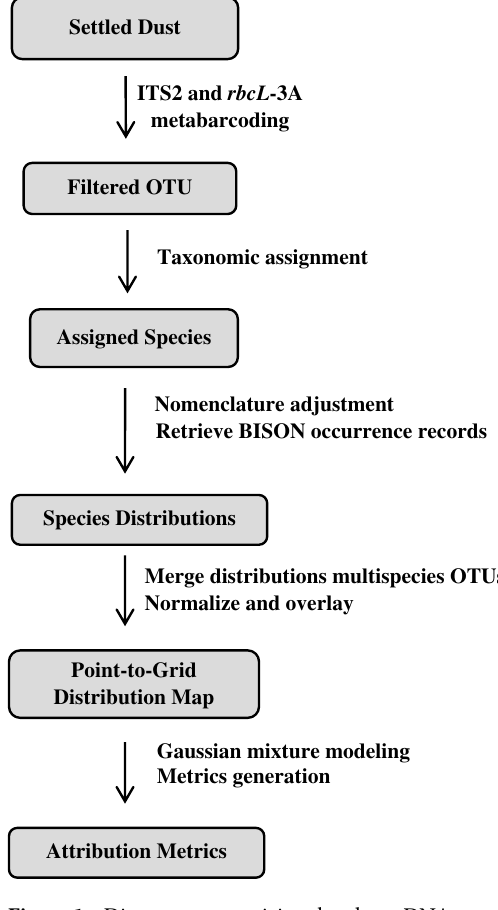
Figure 1. Diagram summarizing the plant eDNA geographic attribution pipeline used in this study. Starting from settled dust, DNA is extracted then subjected to metabarcoding with ITS2 and rbcL -3A, sequencing, and data processing to obtain an estimate of the site of origin.